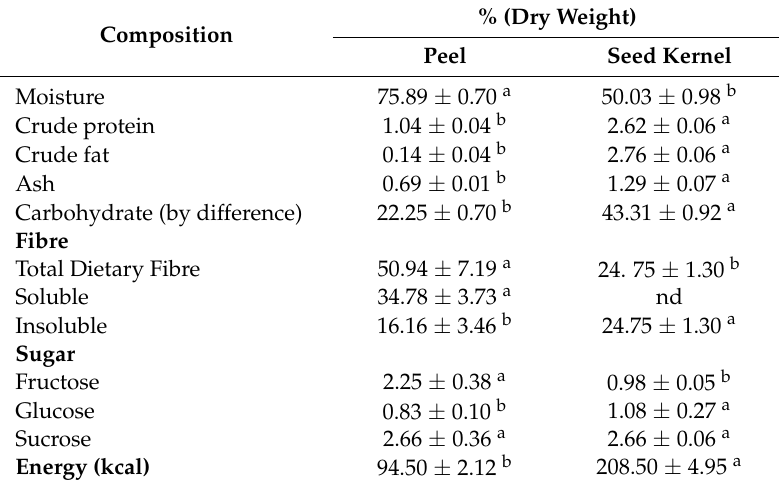
Table 1. Proximate composition of M. odorata peel and seed